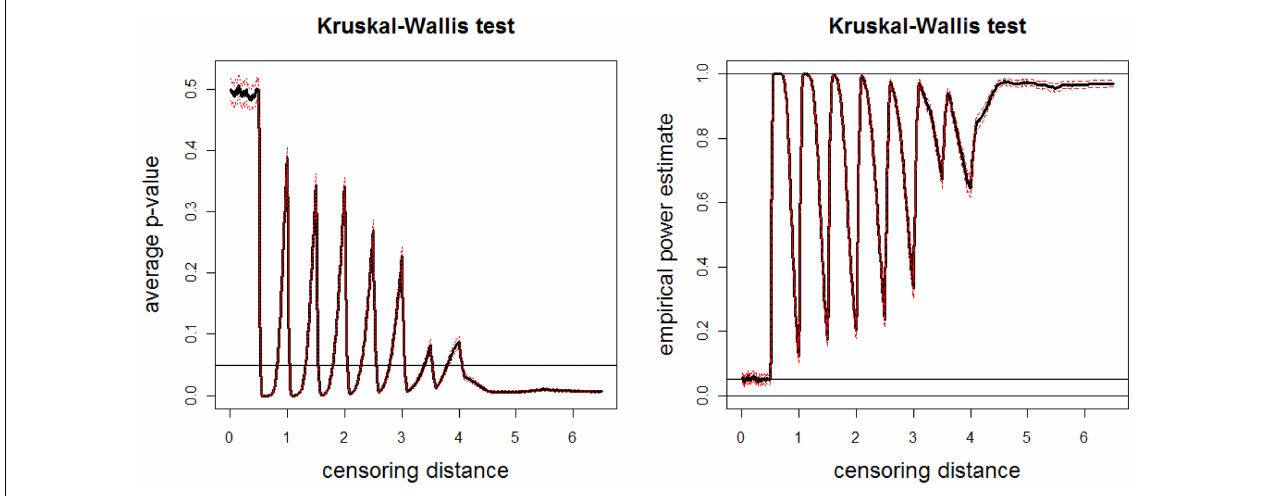
FIGURE 10 | Plotted in the left is the average p -values (solid line) and in the right is the empirical power estimates (solid line) versus censoring distance values for multi-group K–W test together with the 95%